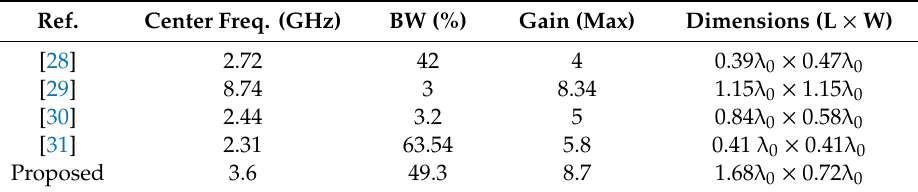
Table 1. Comparison of wideband printed Yagi Antenna with proposed work.